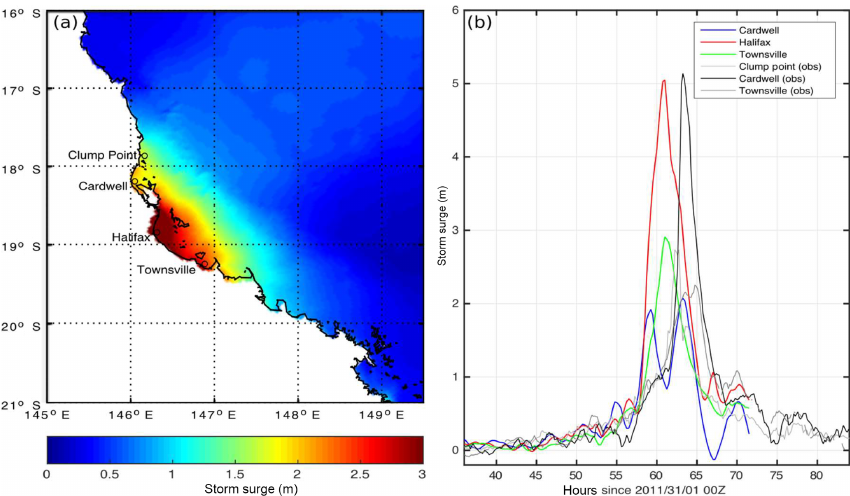
Figure 3. (a) Maximum simulated storm surge over the CTRL simulation. Open circles indicate location of tide gauge observations and simulation output locations, respectively. (b) Simulated and observed storm surge levels at locations plotted in (a) .